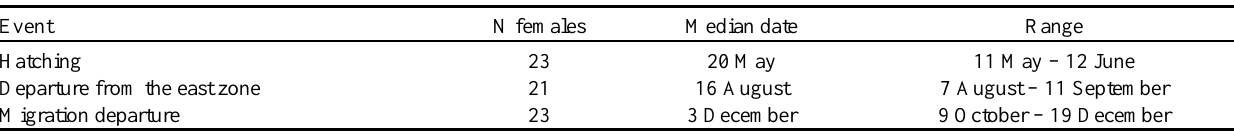
Table 1 . Chronology of hatching, departure from the east zone of the study area, and departure for the fall migration of radio- collared Canada Geese ( Branta canadensis maxima ) marked near Montréal, Québec, 2004. Event N females Hatching Departure from the east zone Migration